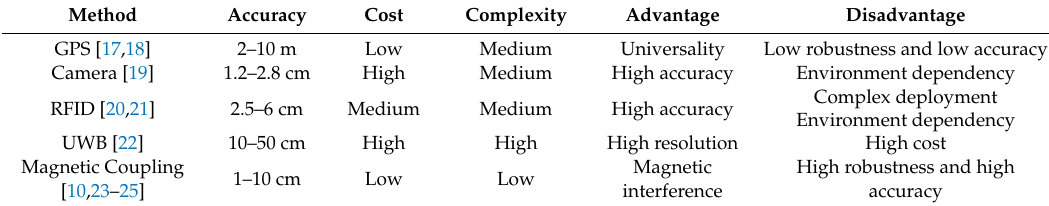
Figure 1. Coil misalignment diagram. Table 1. Comparison of existing positioning methods.